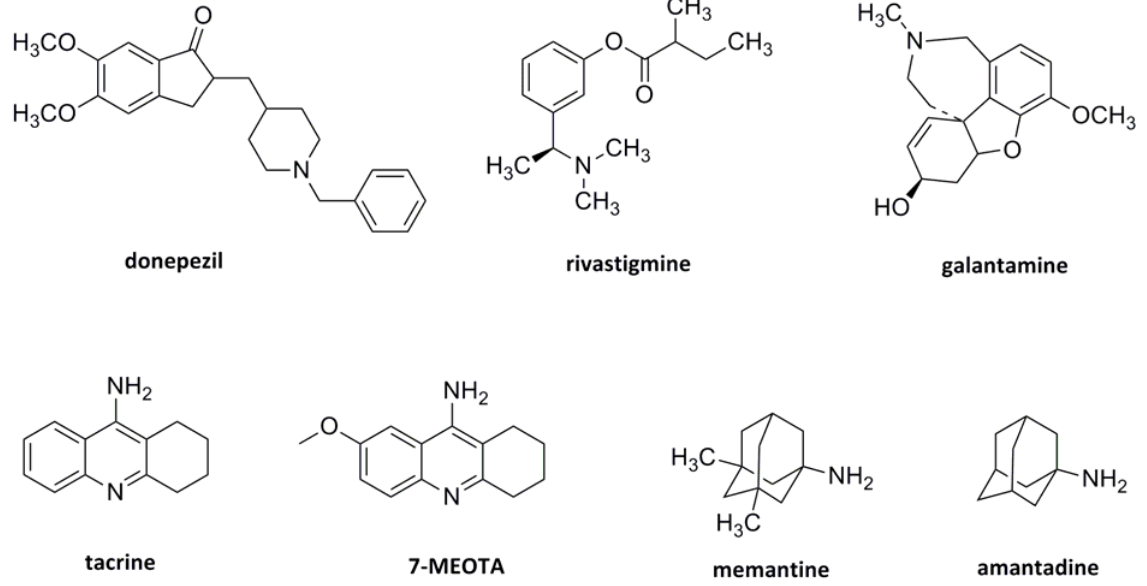
Figure 1. Structures of ChEIs, tacrine derivatives and polycyclic